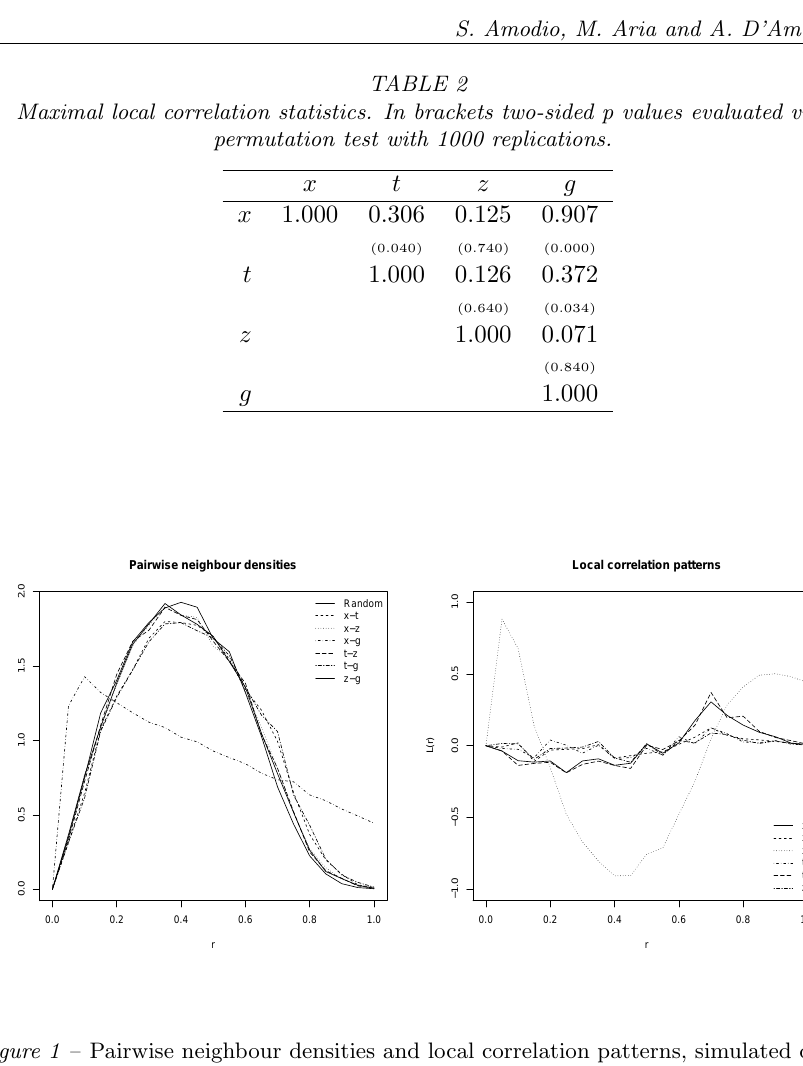
Figure 1 { Pairwise neighbour densities and local correlation patterns, simulated data .